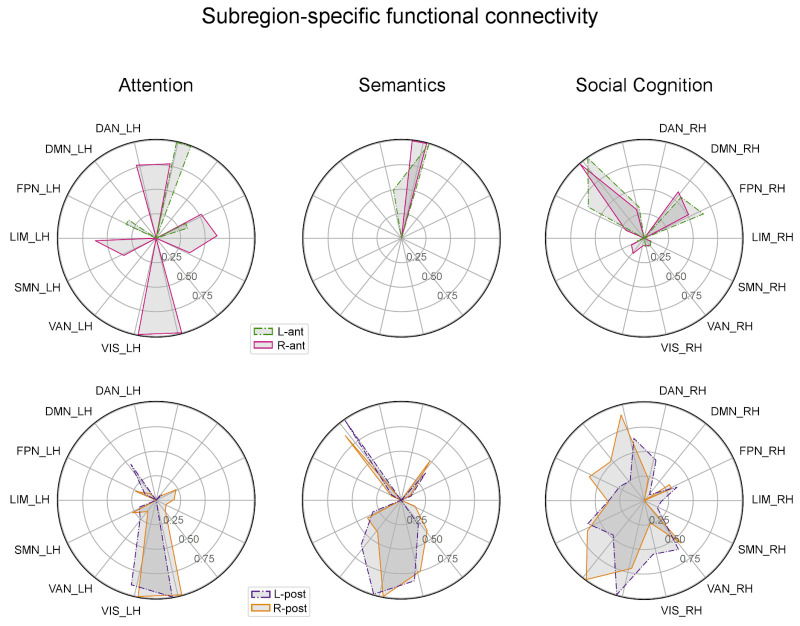
Subregion-specific functional connectivity.The preferred connectivity between IPL subregions and brain-wide cortical regions identified task-specific coupling motifs of the four subregions. Large-scale brain networks were split into their left and right hemispheric parts. Functional connectivity was normalized per subregion and task. Anterior IPL subregions (top row) connect in a hemisphere specific way, while posterior IPL subregions (bottom row) connect in a more bilateral-symmetric way. LH/RH: left/right hemispheric network parts. See main text for details on the connectivity metric. Network acronyms as defined in the main text.